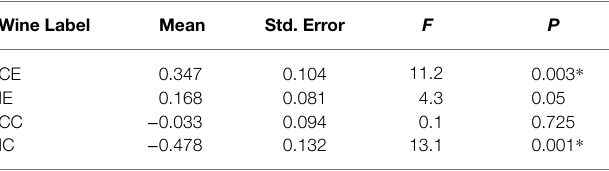
TABLE 2 | Mean of the PCN amplitudes for each bottle/label averaged across sessions from 80–120 ms, standard errors of the mean, and results of F tests as deviation from “0.”